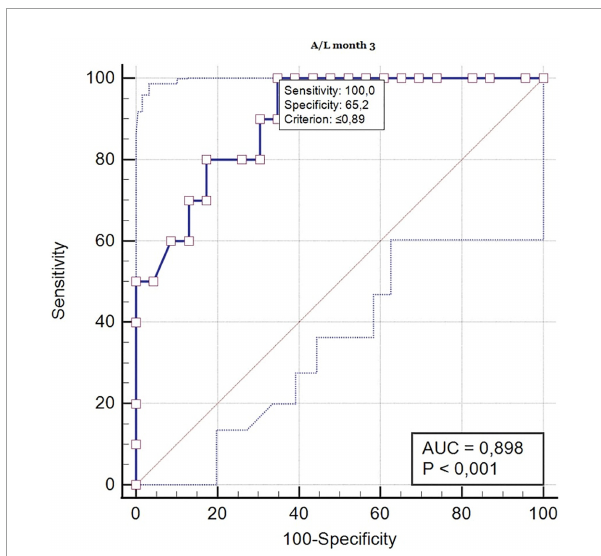
FIGURE2 ROC curve analysis (A/L ratio in month 3 as a predictor for AMR 3 months after kidney transplantation). ROC, receiver operating characteristic; AUC, area under the